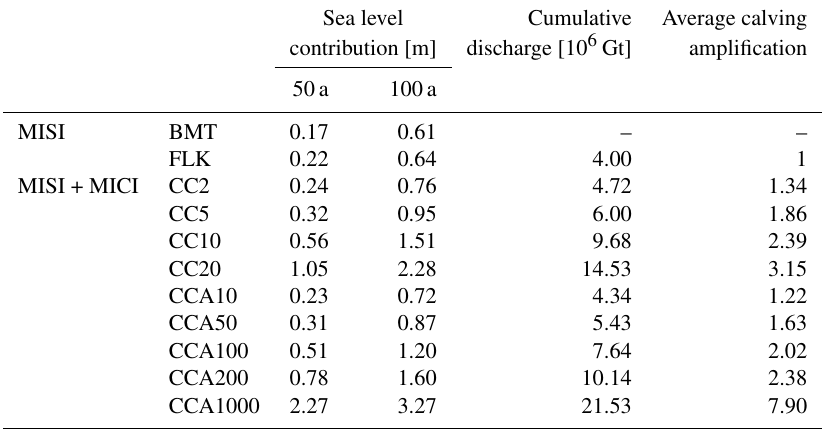
Table 2. Sea- level contribution after 50 and 100a is computed as the difference to the REF simulation. Cumulative calving discharge from the Amundsen region is given after 100a. Average calving amplification is calculated as fraction between overall calving discharge (including cliff calving) and calving discharge only due to the floatkill